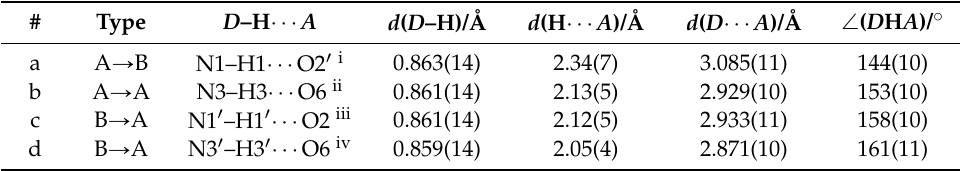
Table 3. Geometric parameters for hydrogen bonds in 2 .